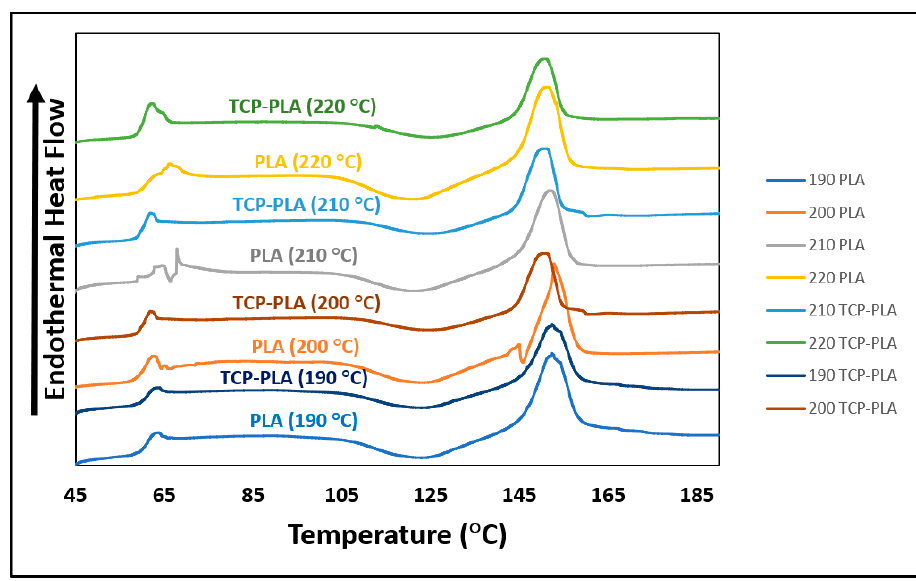
Figure 7. DSC results of PLA and TCP–PLA filaments. Table 1. Thermal properties of PLA and TCP–PLA filaments obtained from DSC.